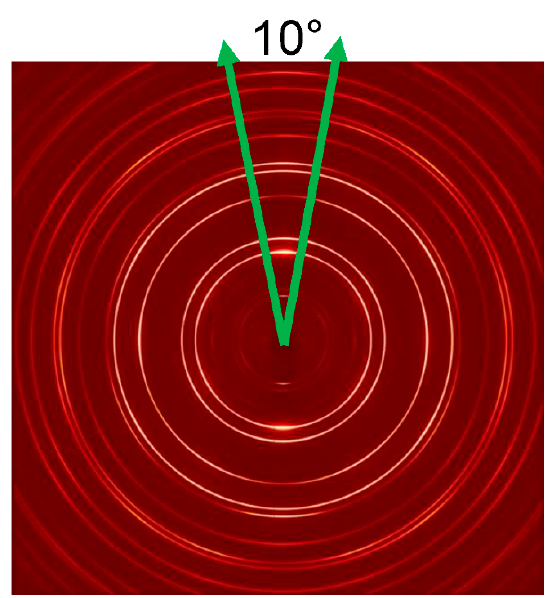
Figure 6. Debye–Scherrer rings for a Cu tube and the integration sectors along the drawing direction.